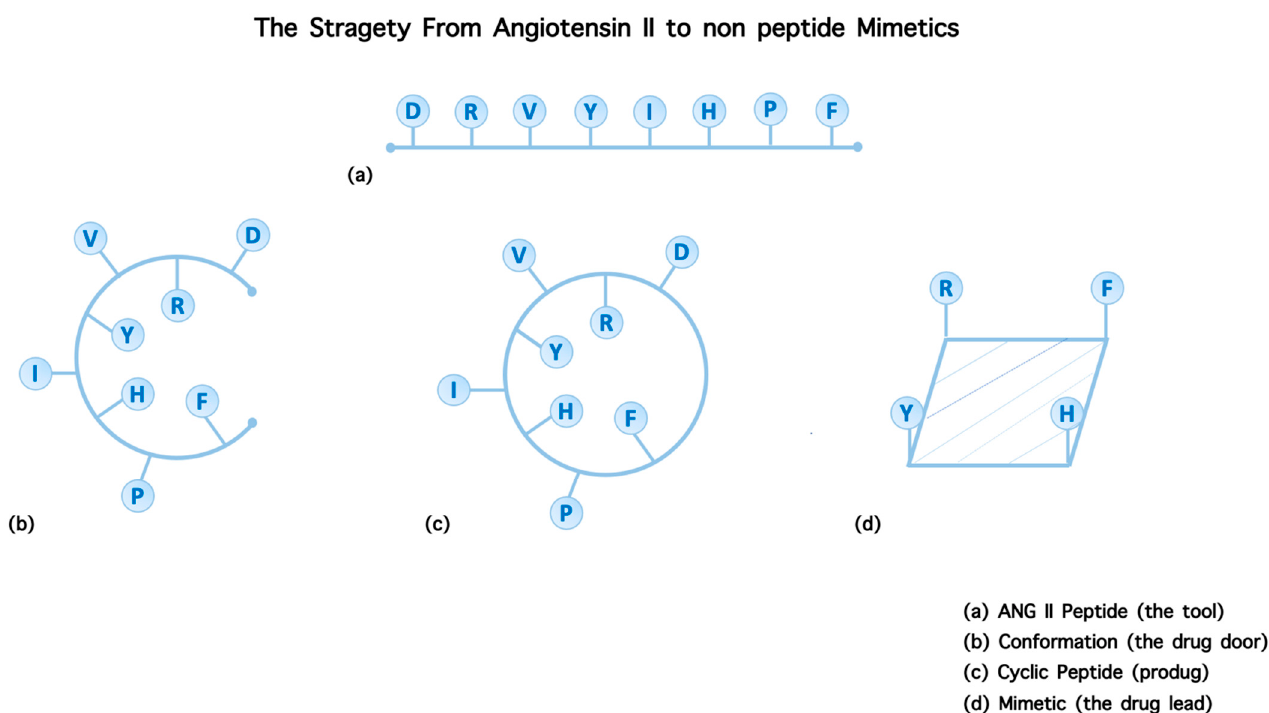
Figure 2. Steps of the strategy to design a non-peptide ANG II mimetic. ( a ) ANG II peptide (the tool)—SAR studies to identify the critical amino acids. ( b ) Conformation (the drug door)—NMR/NOE studies to approach the bioactive conformation. ( c ) Cyclic peptide (prodrug) —cyclization at positions least important for activity. ( d ) Mimetic (the drug lead)—synthesis of a non-peptide mimetic based on critical amino acids.